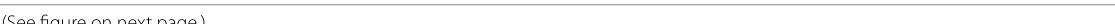
level(See figure on next Fig. 4 Local wavelet power spectra normalized by 1/σ 2 (σ expressed in m 3 s − 1 ). The shaded contours are at normalized variances (m 3 s − 1 ) 2 . The left axis is the period (in years). The bottom axis reports the time (in years). The thick black contour encloses regions of greater than 95% confidence for a red-noise process with a lag-1 coefficient of 0.72. a The yearly averaged discharge rates from 1922 to 2021 showing the long-term periodicity of ca. 10 years from 1942 to 2002 (green circle); b the monthly averaged discharge rates from February 2000 to December 2021 showing the intermediate-term periodicities of ca. 3.5 from 2007 to 2017 (green circle; c the weekly averaged discharge rates from 2000 to 2021 showing the short-term periodicities of ca. 1 year (dotted green circle), ca. 6 months from 2011 to 2014 (green dotted circles) and ca. 3–4 months during 2001–2003 (dotted green circles). It is worth noting that 1 year periodicity is also detected in b During 2001–2003 and 2011–2014. The global wavelet power spectra are shown on the right side of each plot. The orange dotted line represents the best-fitting red-noise spectrum at the 95% confidence